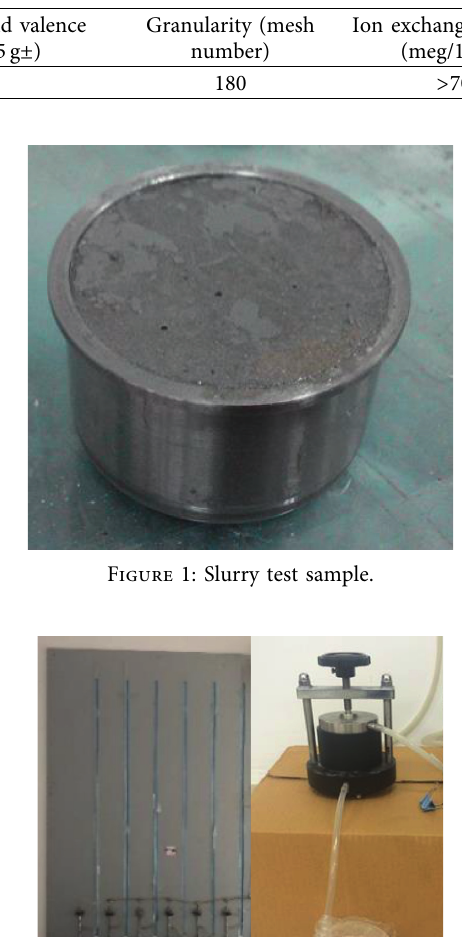
Table 1: Performance indicators of bentonite.